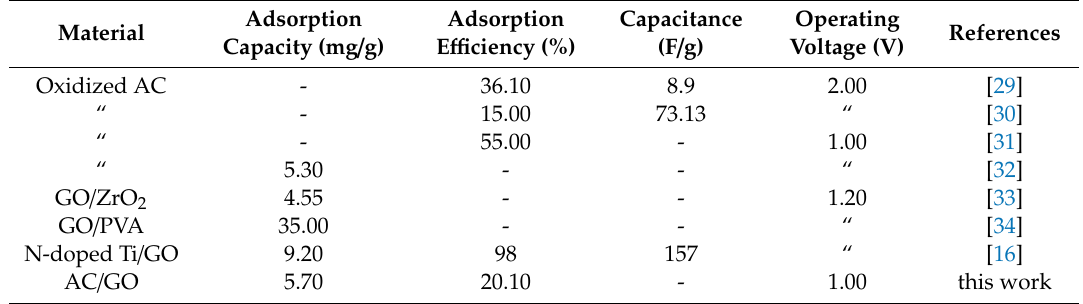
Table 5. CDI performance matrices of AC and AC/GO-15 electrodes at all operating conditions.